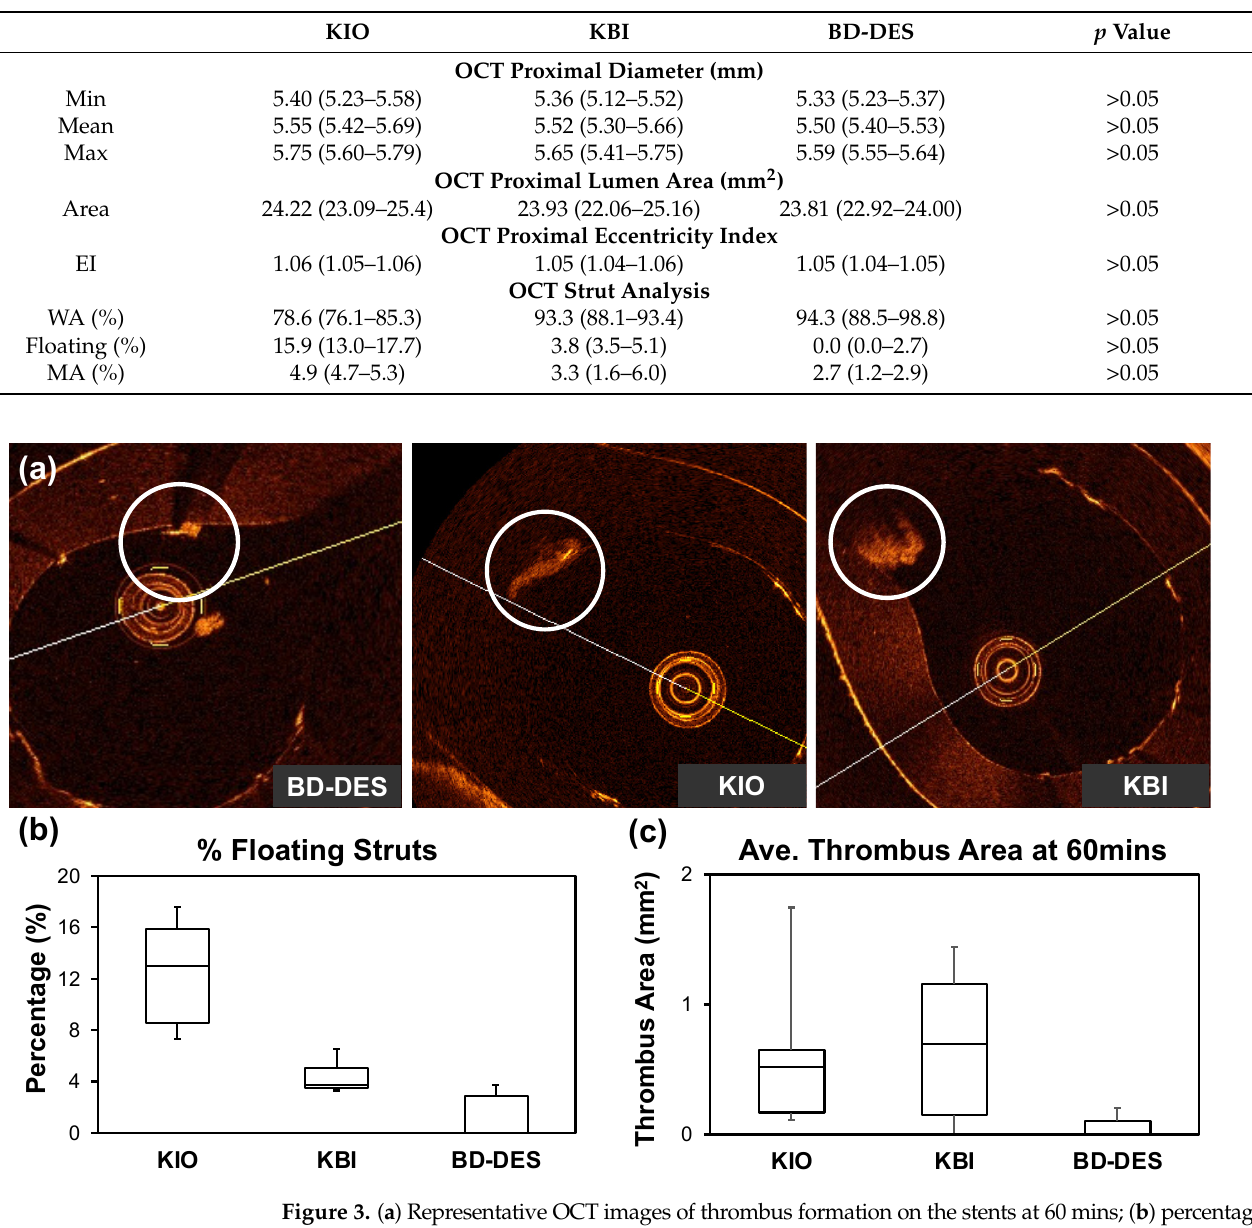
Table 1. OCT analysis of stents overexpansion ( n = 5).